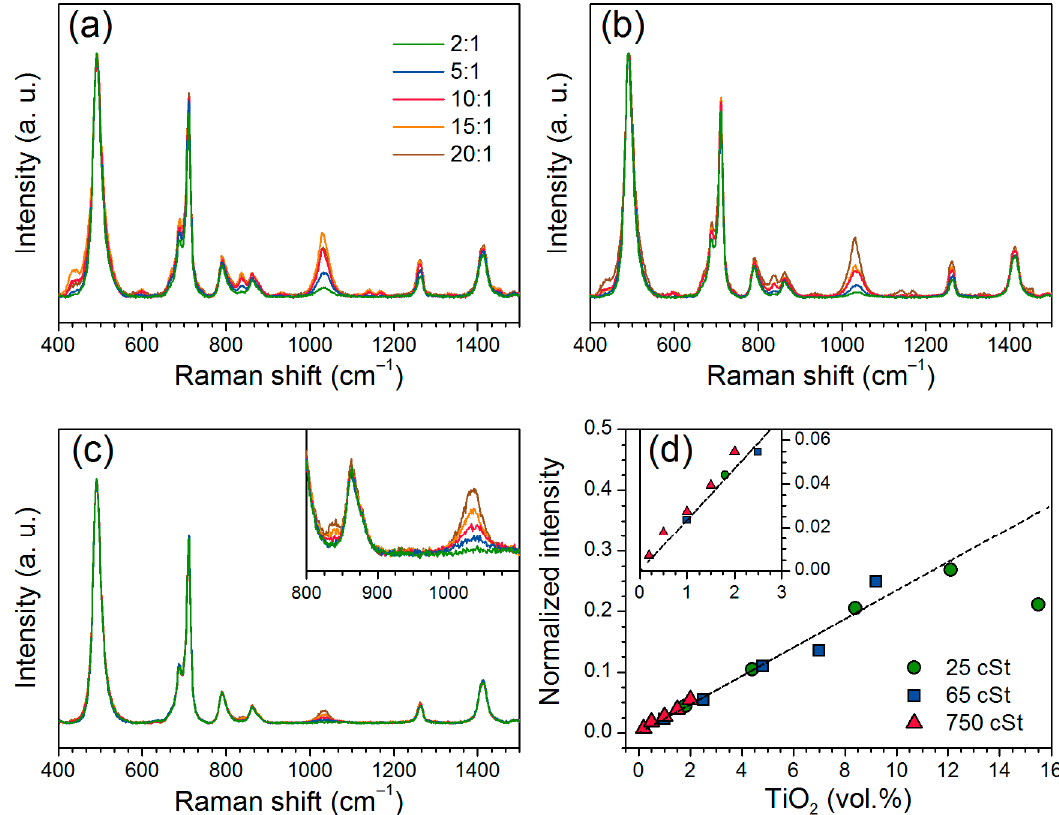
Figure 4. Raman spectra of Ti-PDMS hybrid materials prepared using PDMS-OH precursors with viscosities of ( a ) 25 cSt, ( b ) 50 cSt and ( c ) 750 cSt for different TIP/PDMS-OH molar ratios. The spectra are normalized to the Si–O–Si band at 495 cm − 1 . ( d ) Normalized intensity of the band at 1030 cm − 1 assigned to asymmetric stretching of Ti–O–Si bonds as a function of the TiO 2 vol. %.